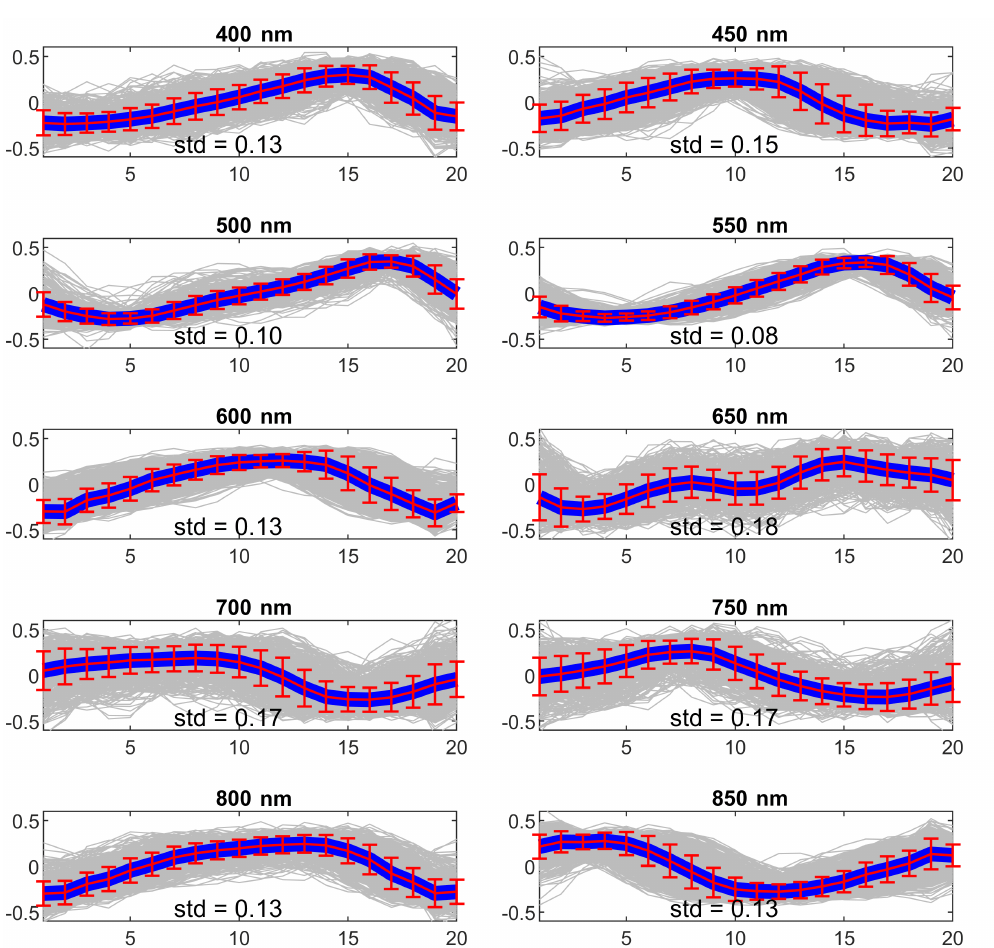
Figure 4. Average beat shape for subject 1 for each one of the wavelengths. Each beat shape is reported in gray and the blue lines represent the average. The red intervals represent the standard deviation for each sampling point. Values on the y -axes are normalized